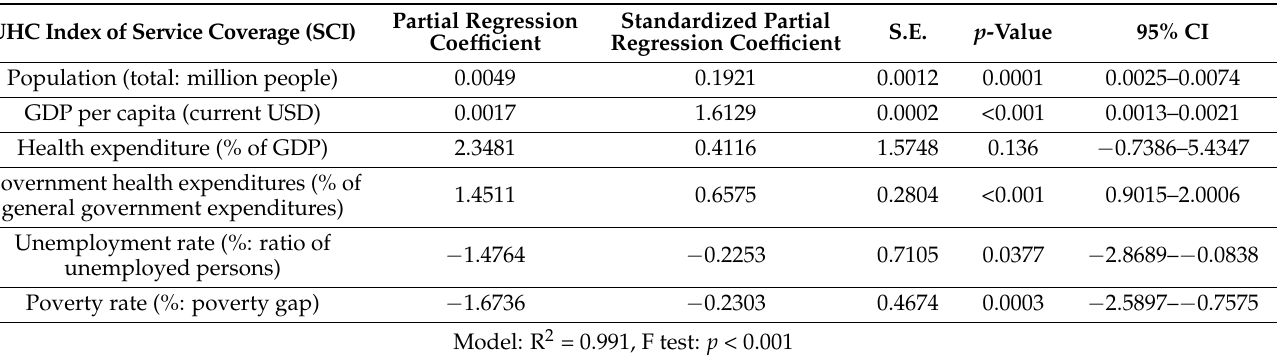
Table 2. Panel data analysis of the impact of economic level (GDP and health expenditure, unem- ployment, poverty) on SCI.